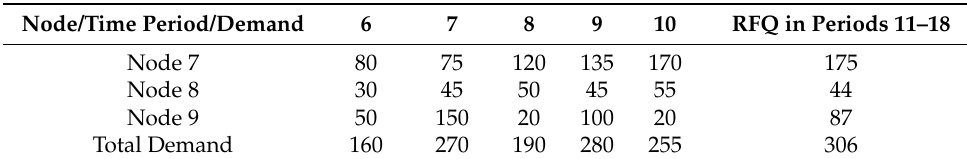
Table 8. Demand data for DPPNL computations.